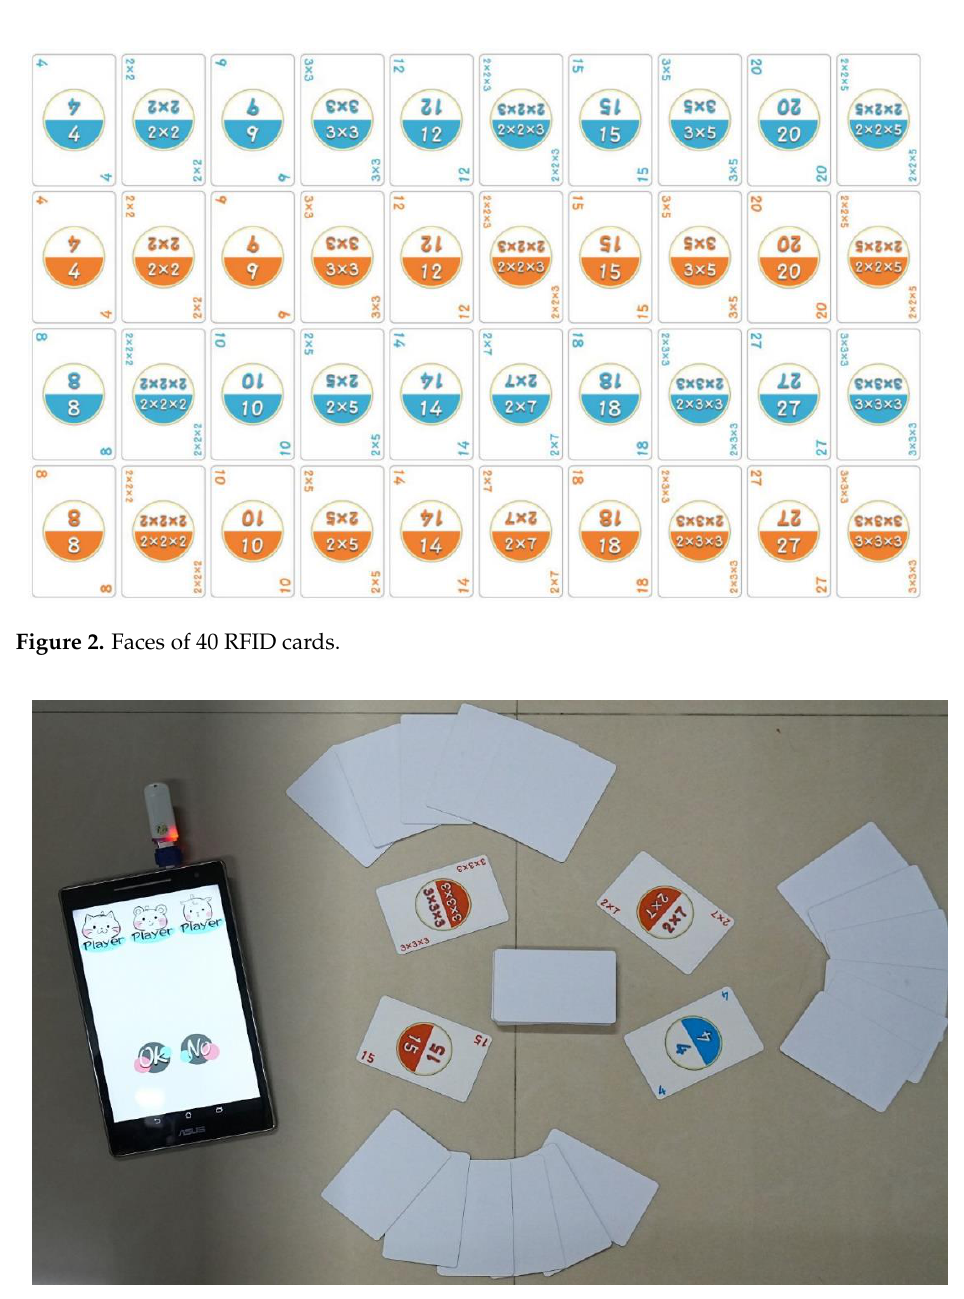
Figure 3. The board game settings.